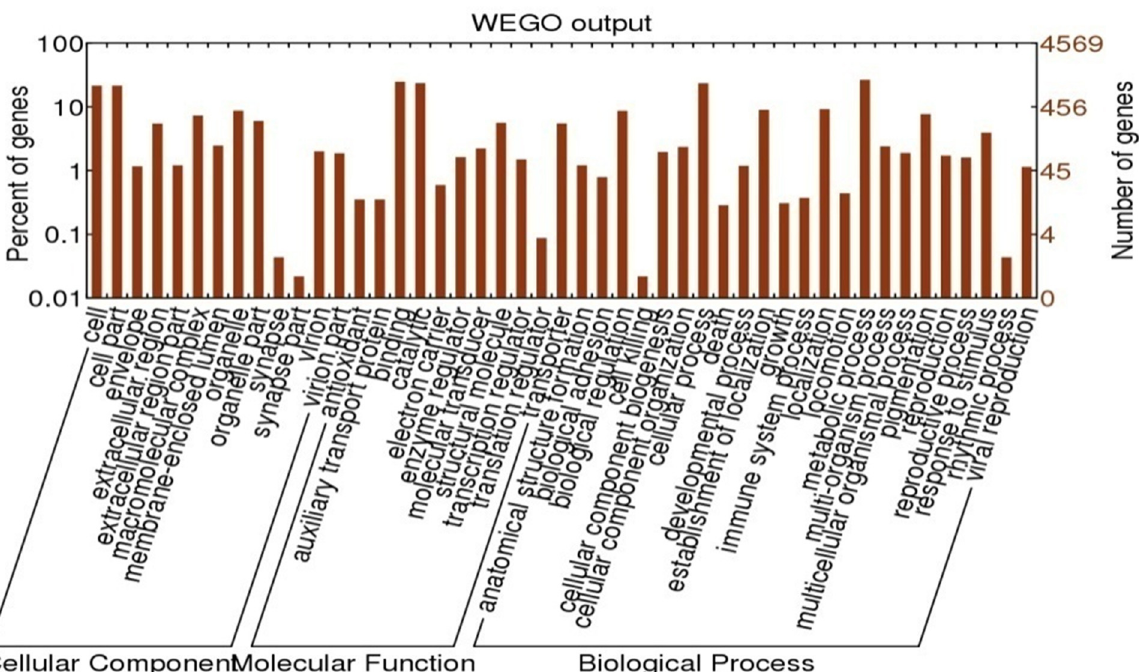
Fig 4. Gene ontology (GO) classification of all DEGs. The results are summarized in three main GO categories (cellular component, molecular function, and biological process). The x-axis represents GO subcategories. The left y-axis indicates the percentage of genes. The right y-axis indicates the number of